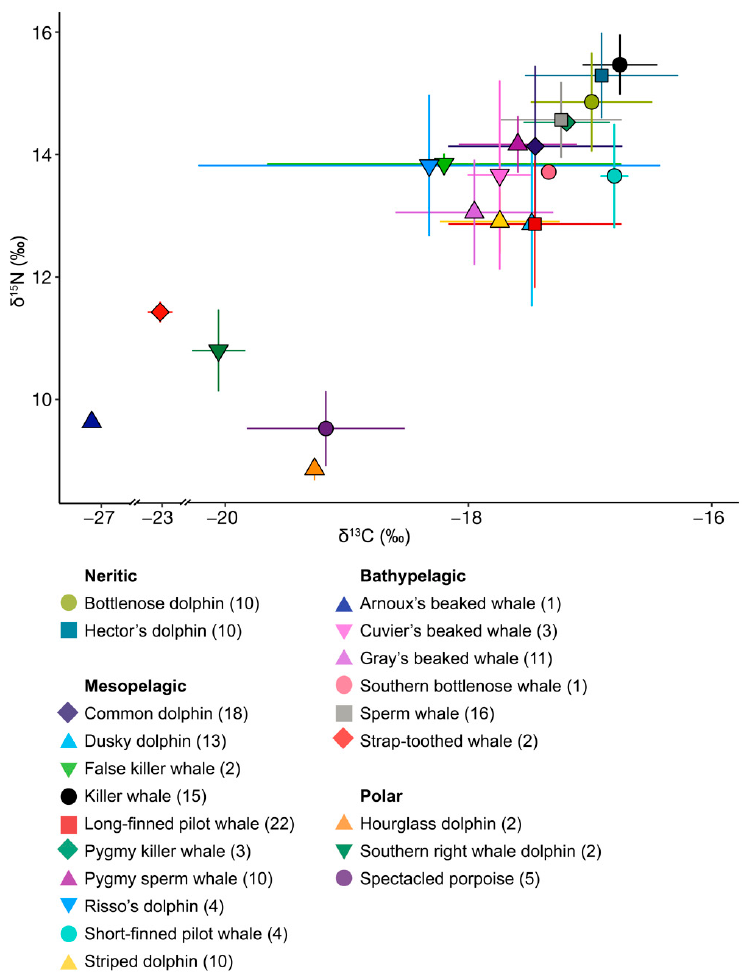
Figure 3. Mean ± 1 standard deviation (SD) of carbon and nitrogen isotope values for odontocete species (denoted by shape and colour) stranded in New Zealand between 2010 and 2021 (for details, see Table 1, for individual values, see Figure A1). Note that the x -axis is split for display purposes. Table 2. Pairwise comparisons (randomisation test) of δ 13 C and δ 15 N isotopic values between odon- tocete species with n ≥ 10 within each habitat group. Colour denotes the level of difference (at 0.05 significance level): dark blue = difference in both δ 13 C and δ 15 N isotopic values, light blue: difference only in δ 15 N isotopic values, white = no difference. Neritic group (yellow): BD = bottlenose dolphin, HD = Hector’s dolphin, mesopelagic group (orange): CD = common dolphin, DD = dusky dolphin, KW = killer whale, LPW = long-finned pilot whale, PSW = pygmy sperm whale, SD = striped dolphin, bathypelagic group (green): GW = Gray’s beaked whale, SBW = southern bottlenose whale, SW = sperm whale. Dark grey indicates matrix diagonal, light grey fields refer to species not in the same habitat. See Table A1 for p -values.